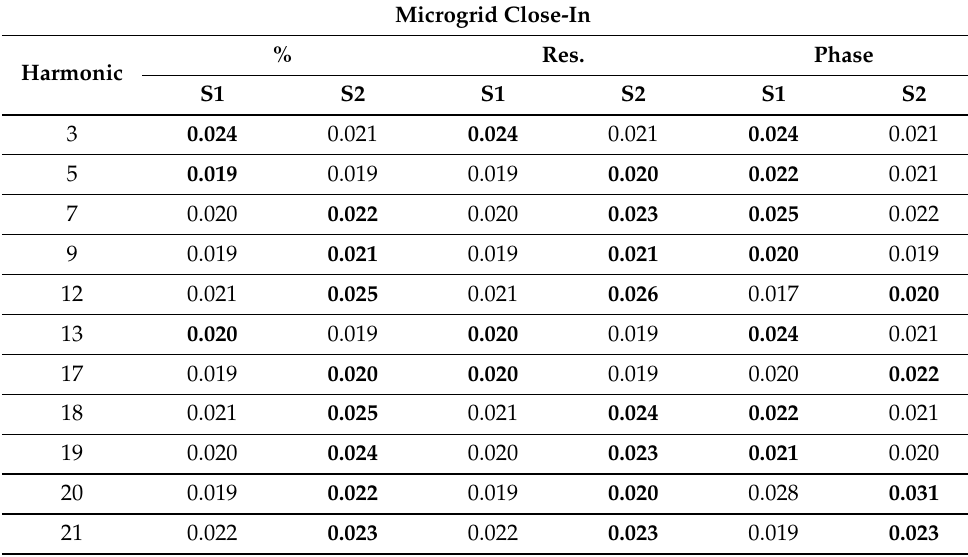
Table 6. RMSE for Microgrid Close-in Harmonic